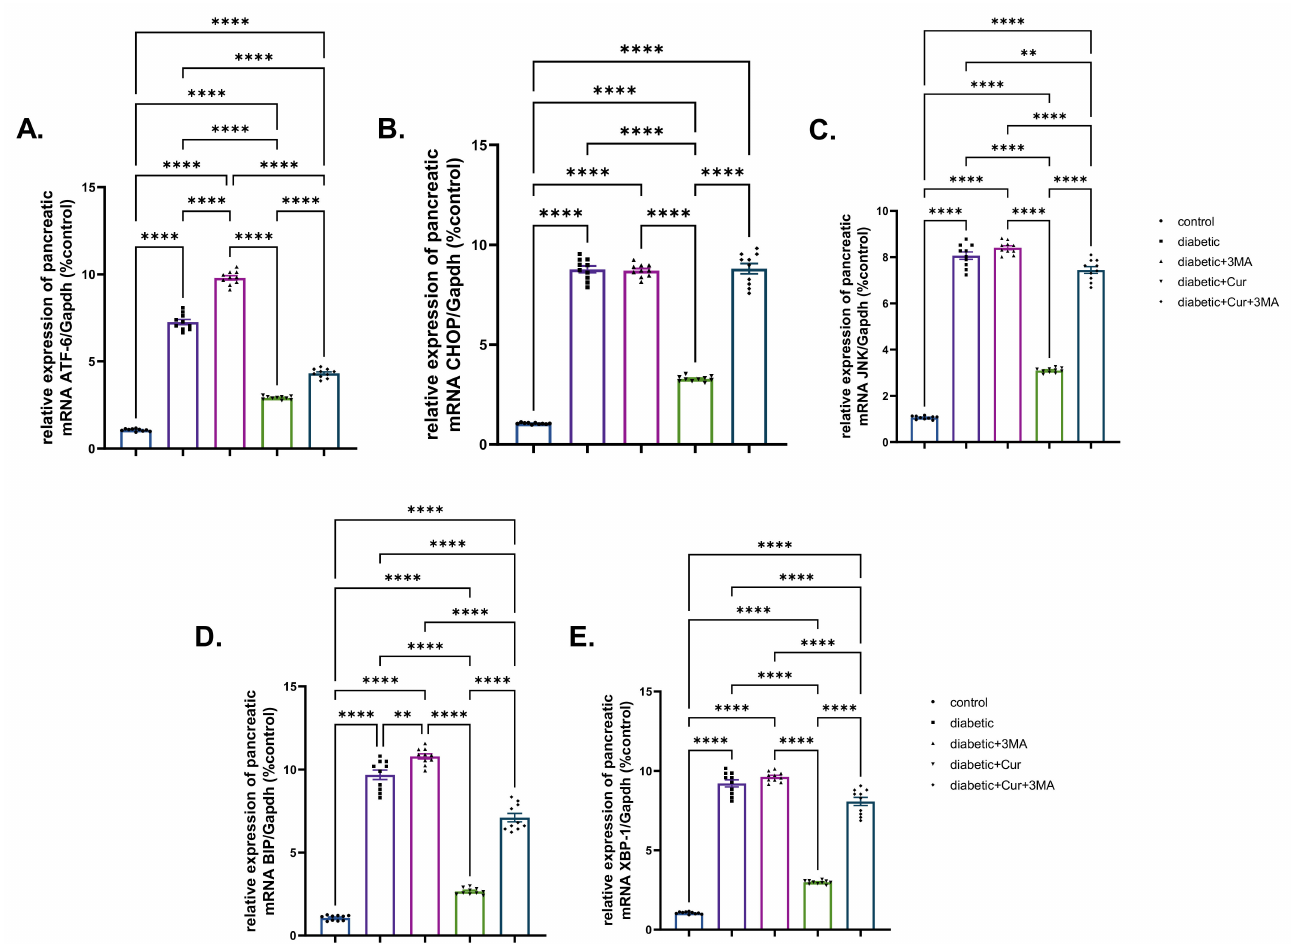
Figure 5. Effect of diabetes (STZ) (65 mg/kg b.wt), 3MA (10 mg/kg b.wt), LPs-CUR (10 mg/kg b.wt.) oral dosing for 10 weeks on the expression pattern (Fold change) of genes by qRT-PCR ( A ) Atf-6, ( B ) CHOP, ( C ) JNK., ( D ) BIP, ( E ) XBP-1 in pancreatic tissue of all diabetic and vehicle control